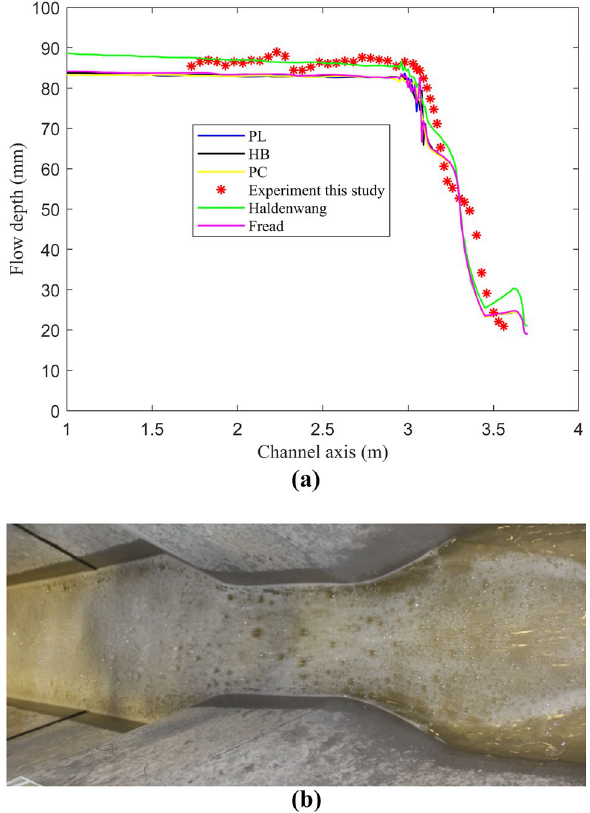
Fig. 5 A comparison of different friction models for the flow depth variation along the channel axis: The channel inclination is α = 0°. The inlet flow rate is 433 kg min −1 . a Experimental and simulated flow depth comparison, b steady-state image of the free surface